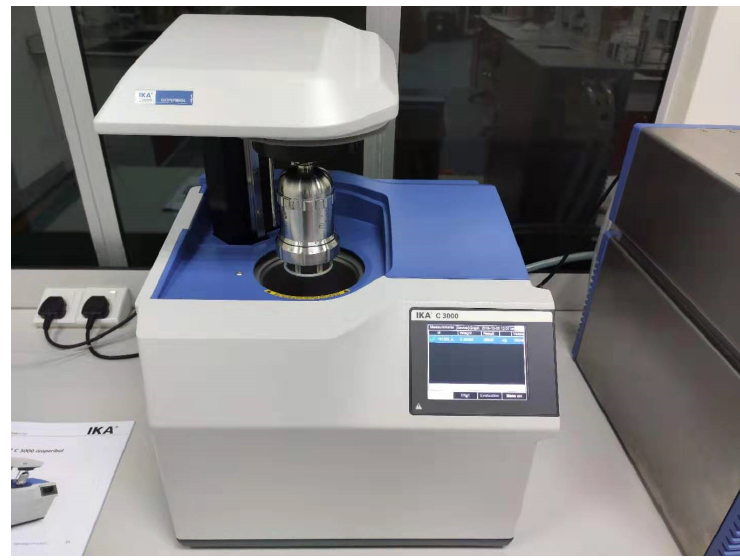
Figure 5. IKA calorimeter